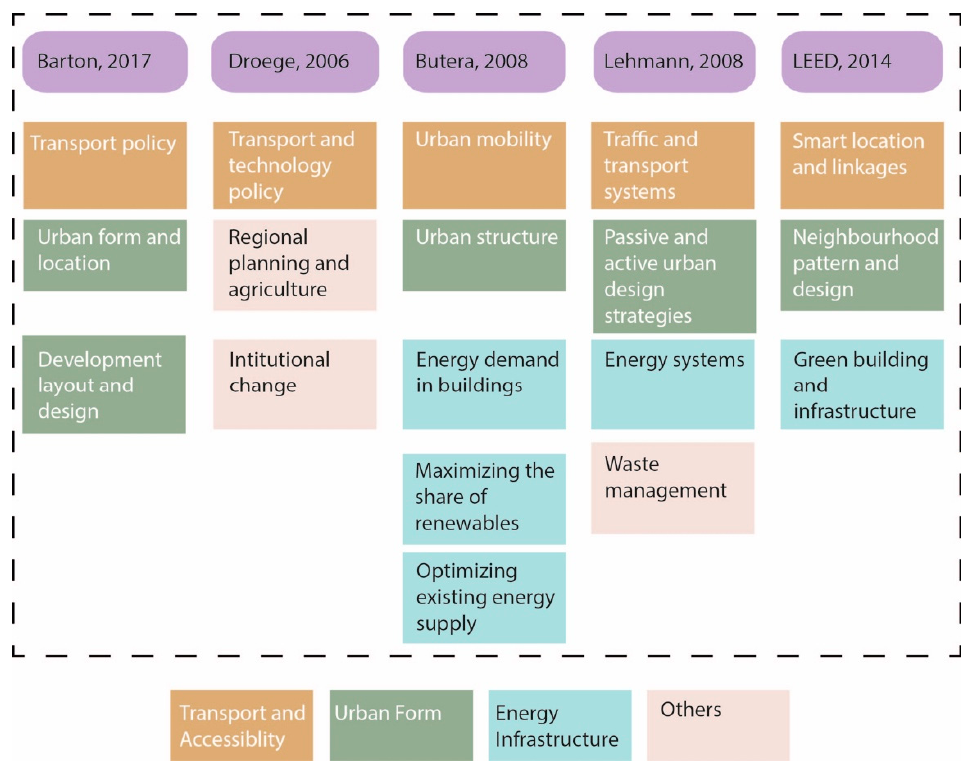
Figure 1. Urban components of the energy transition.